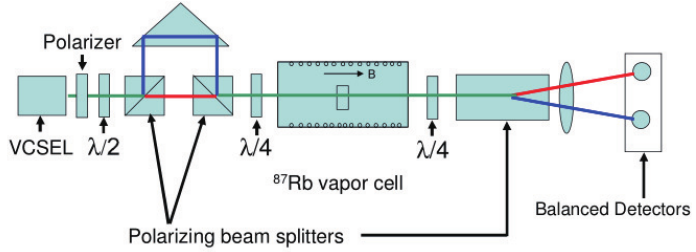
Figure 10. The experimental setup for differential detection